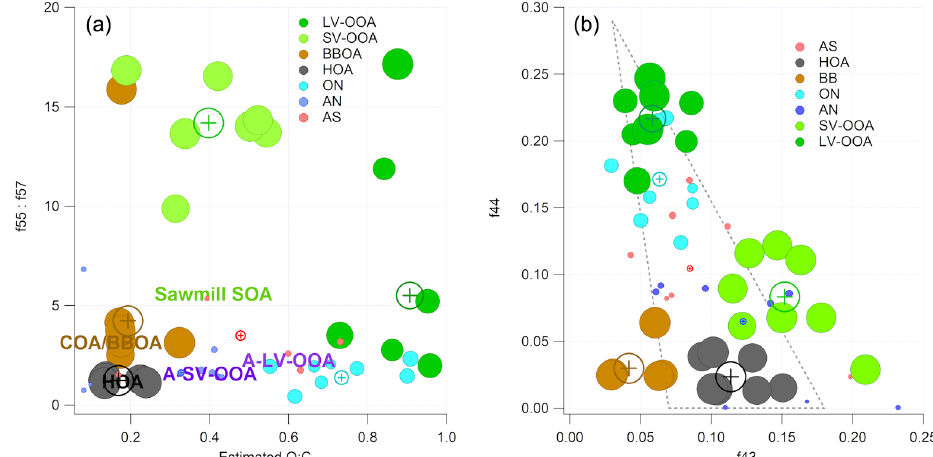
Figure 7. (a) P-III (r-CMB) solution – cluster projections onto a f 55 /f 57 (Mohr et al., 2012), O:C (estimated, Aiken et al., 2008) plane. Circles correspond to the members of the cluster and the cross markers to cluster centroids. The text markers indicate respective positions of anthropogenic organic aerosol types from Äijälä et al. (2017). Marker size indicates organic mass fraction in spectra. Axes are truncated. (b) P-III solution, projected onto the f 44 – f 43 plane (i.e. the “Sally’s triangle” plot; Ng et al., 2011). Circles correspond to objects in clusters and the cross markers to cluster centroids. Marker size indicates organic mass fraction in spectra. A dotted line marks the area where most laboratory data for organic aerosol falls (Ng et al.,